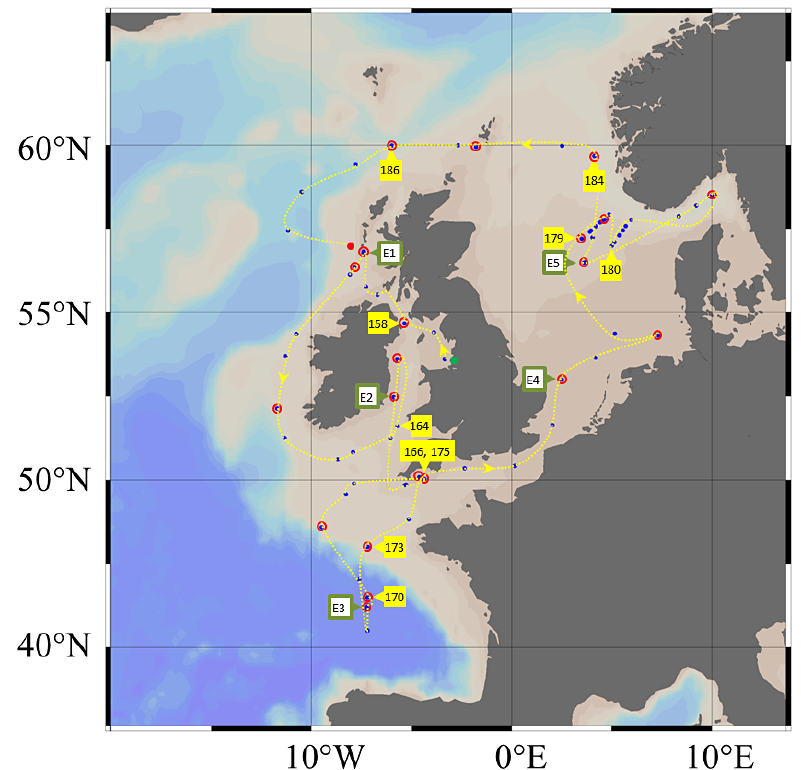
Figure 1. Station locations sampled within the NW European shelf sea area; stations for temperature and nutrient profiles (Fig. 3) are rep- resented by blue circles; stations for N 2 O profiles (Fig. 3) are represented by open red circles; stations for nitrogen cycle measurements (Figs. 4, 5) are represented by yellow-box arrows which include Julian day; ocean acidification bioassay experiments (Figs. 8, 9) are repre- sented by green-box